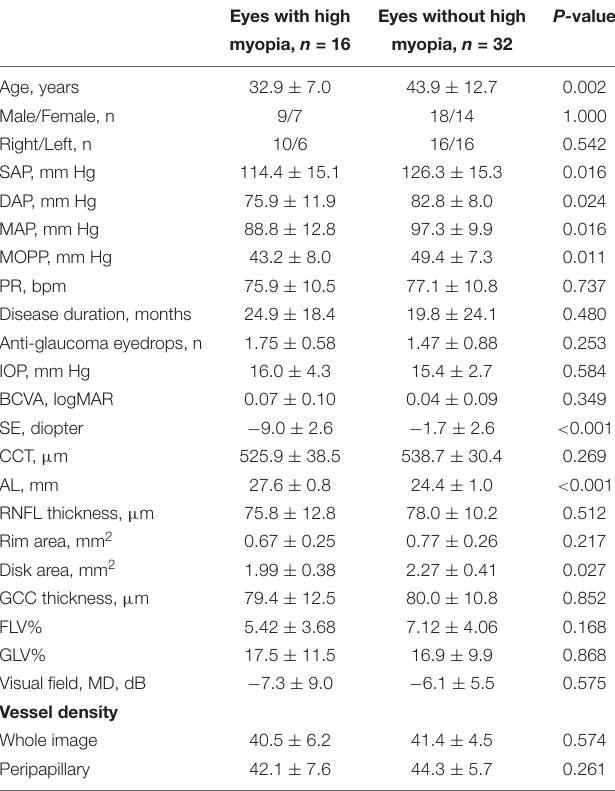
TABLE 1 | Baseline and demographic data.